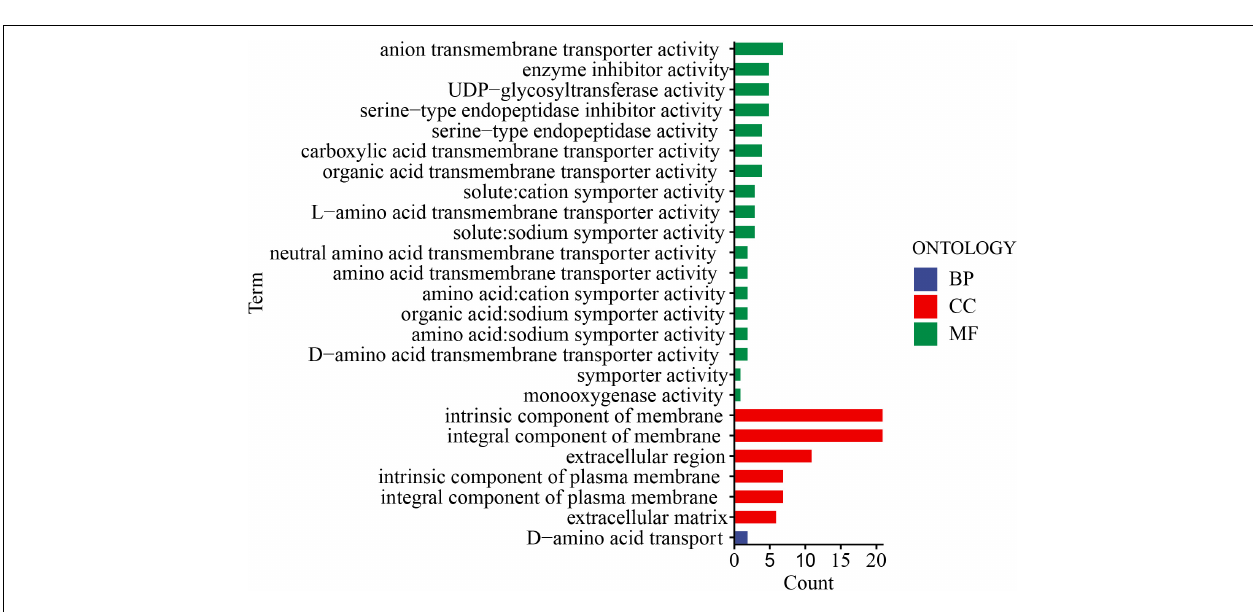
FIGURE 3 | The top 25 of gene ontology (GO) terms significantly enriched by differentially expressed genes